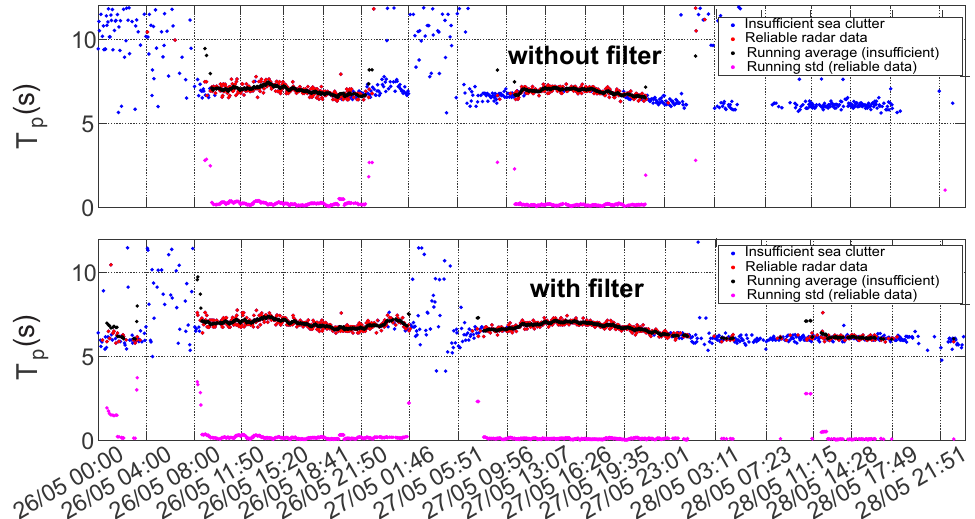
Figure 12. Time series of the peak period before ( upper panel ) and after ( lower panel ) streak filtration given together the moving average and std, calculated with the 20 min window